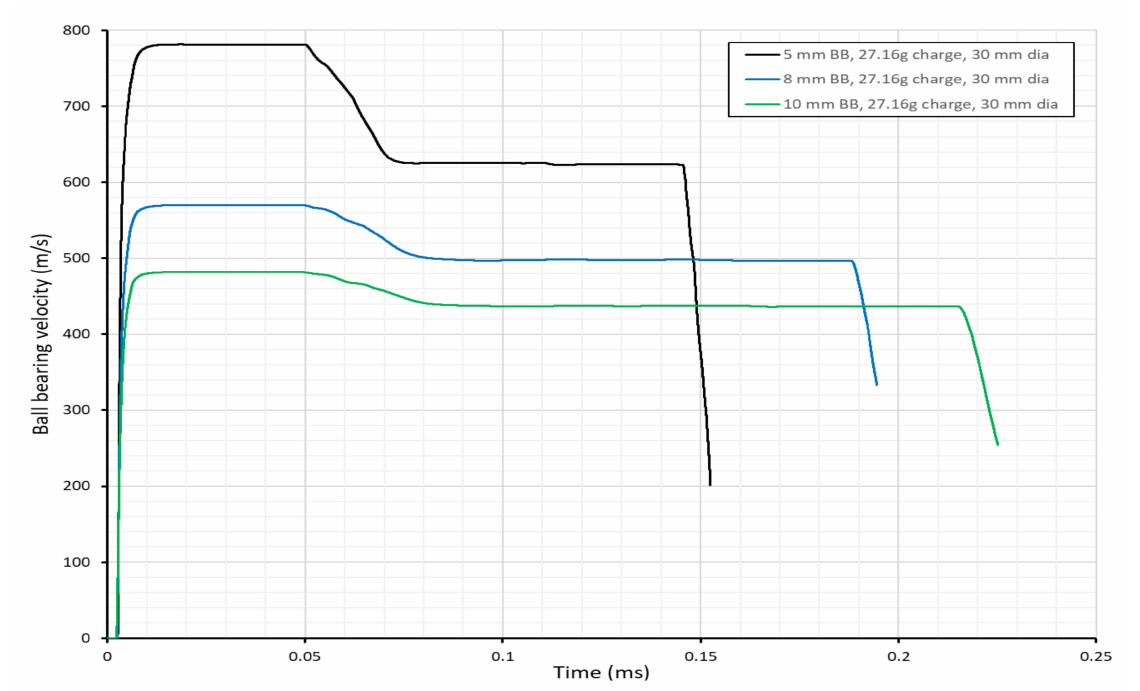
Figure 11. Simulated velocity–time histories for 27.16 g charge mass (30 mm charge diameter) detonations with different sized ball bearings.